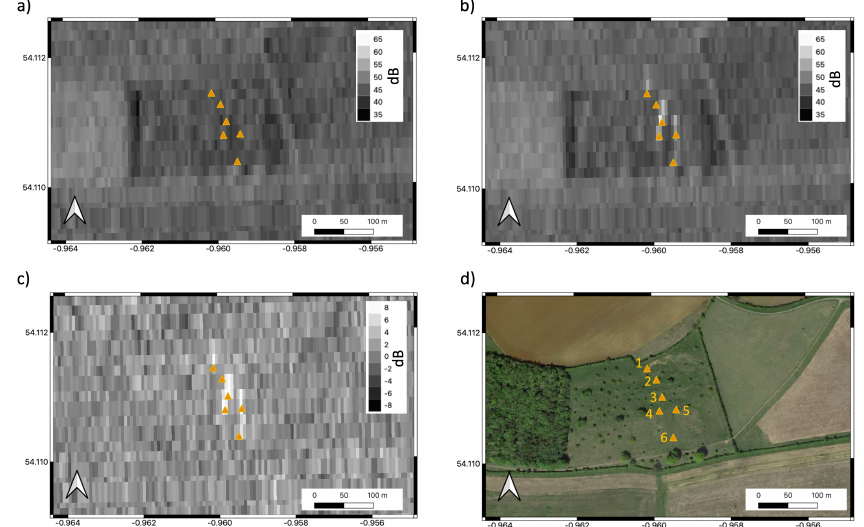
Figure 6. Improvement in intensity in the ascending acquisition due to the installation of corner reflectors (orange triangles) on 17 July 2019. Average amplitudes of ascending acquisitions between July 2018 and 8 July 2019 ( a ), between 20 July 2019 and February 2021 ( b ) and the difference between them ( c ). ( d ) A satellite image of the area. Note the different scale for the image of the